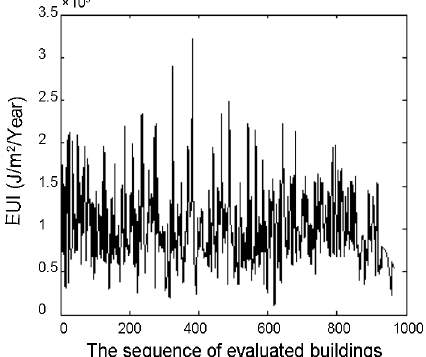
Fig. 13. Variation in Energy Use Intensity for the evaluated building samples (3 years